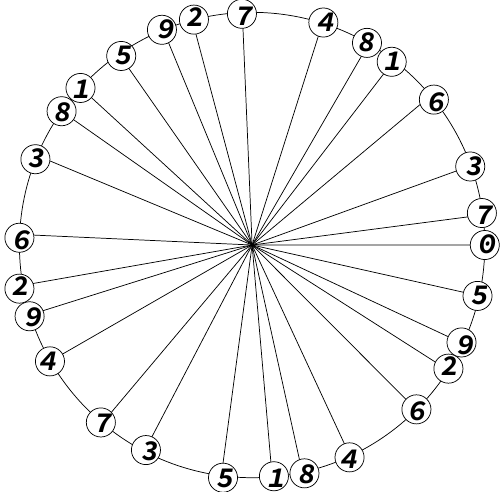
Figure 3. Optimal arrangement of leaves on a